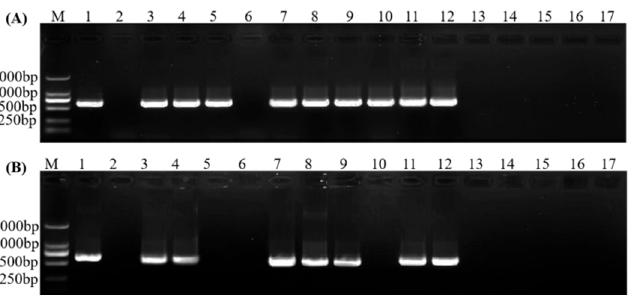
Figure 3. Results of nested PCR using primers ( A ) R16F2n/R16R2 followed by ASF1/ASR1 and ( B ) R16mF2/R16mR2 followed by ASF1/ASR1 for SPLDaP detection in sisal samples. Lane M: marker DL2000; lane 1: positive control; lane 2: negative control; lanes 3–12: symptomatic samples; lanes 13–17: asymptomatic samples.